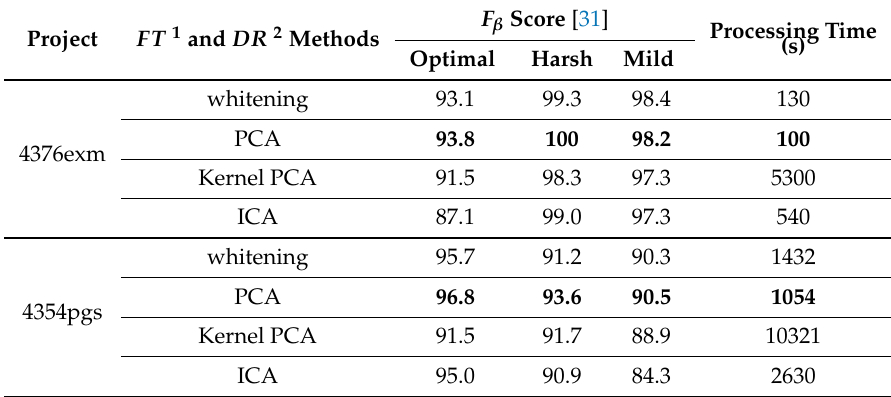
Table 1. Classification and time processing assessment of different feature transformation and dimensionality reduction